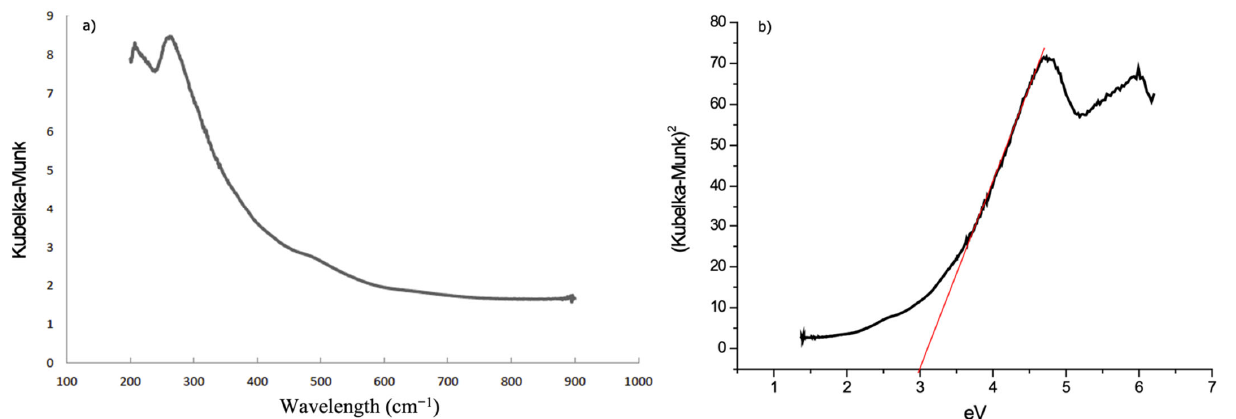
Figure 6. UV/vis spectra in Kubelka–Munk units vs. wavelength ( a ) and ( b ) photonic energy (eV). Red line corresponds to band ‐ gap determination.